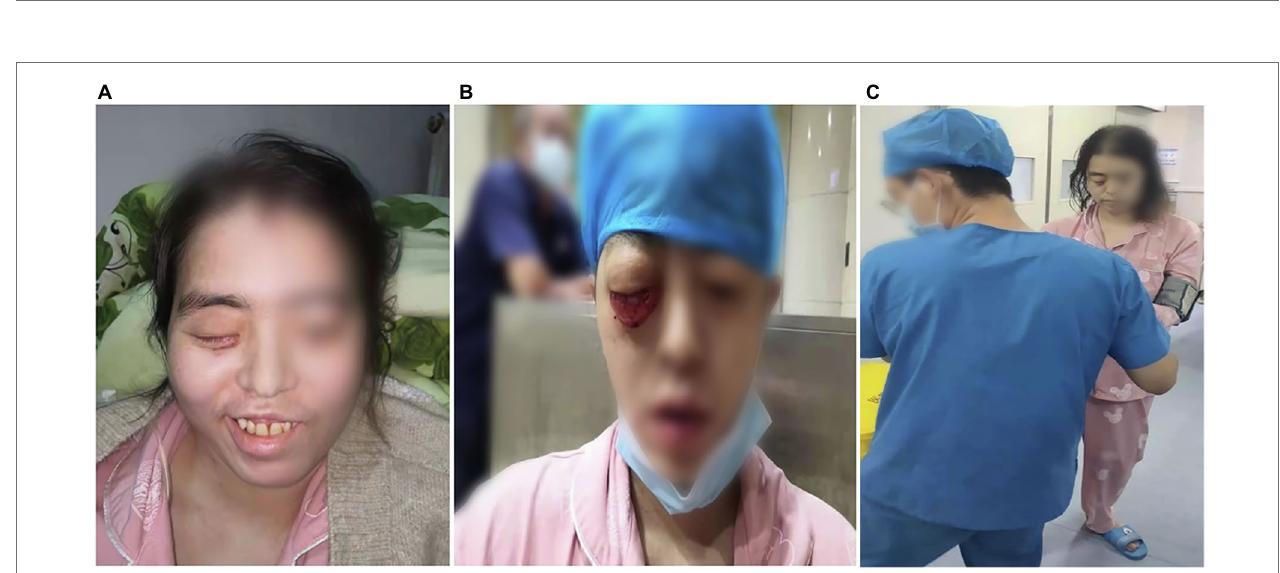
FIGURE 1 | Axial MRI and magnetic resonance angiography of the brain on admission and after admission. (A) Inflammation of the sphenoid sinus and sinuses; (B) the frontal lobe lesion; (C) orbital MRI; (D) the normal magnetic resonance angiography; (E) the new cerebral infarction at the right basal ganglia 17 days after admission; and (F) the presentation of frontal lobe lesion after 67 days of treatment.